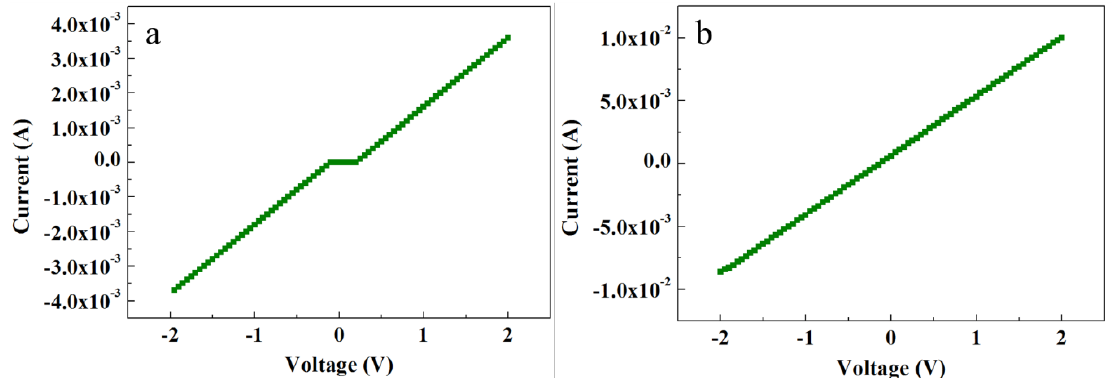
Figure 5. I - V characteristics of ( a ) ACG ZNRs and ( b ) Ga-doped ACG Figure 5. I-V characteristics of ( a ) ACG ZNRs and ( b ) Ga-doped ACG ZNRs.